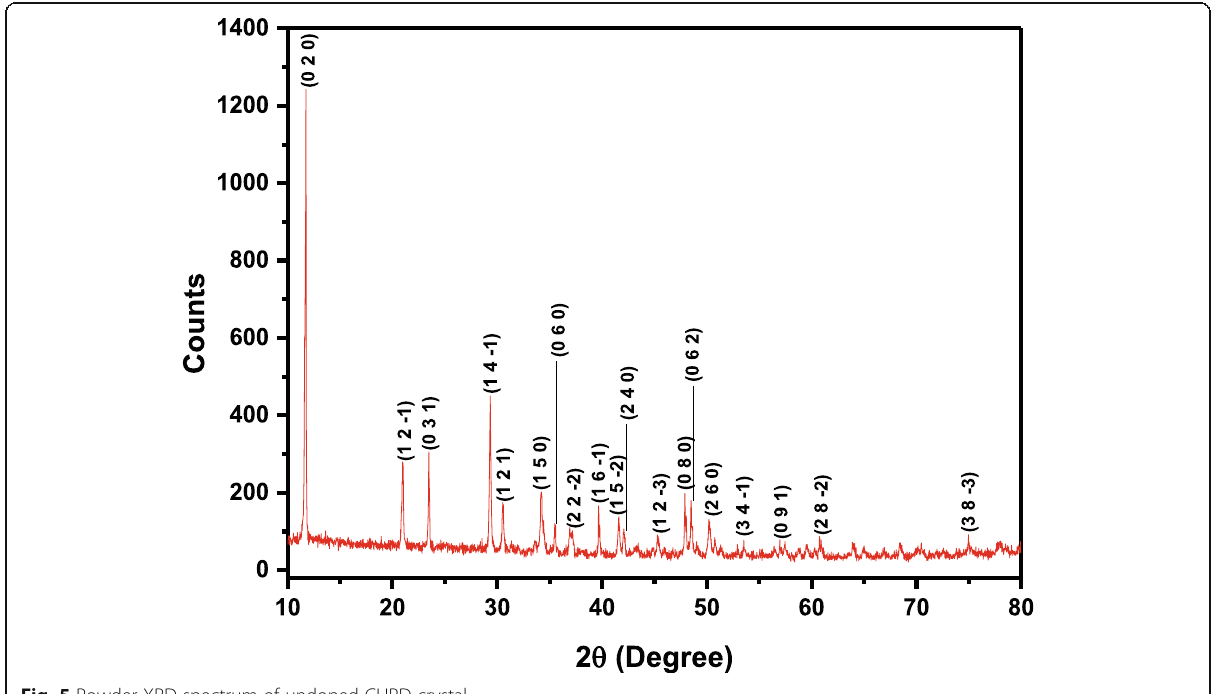
Fig. 5 Powder XRD spectrum of undoped CHPD crystal